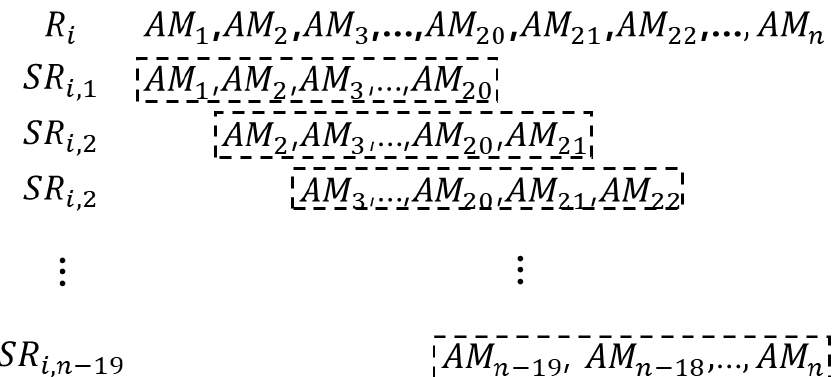
Figure 3. Subsample sets ( SR i , t ) by 20-year moving windows from annual maximum (AM) rainfall series ( R i ) . Note that AM t , R i , n and SR i , t are t th AM events, the AM series of i th station, the number of AM series and t th subsample of the AM series of i th station, respectively.